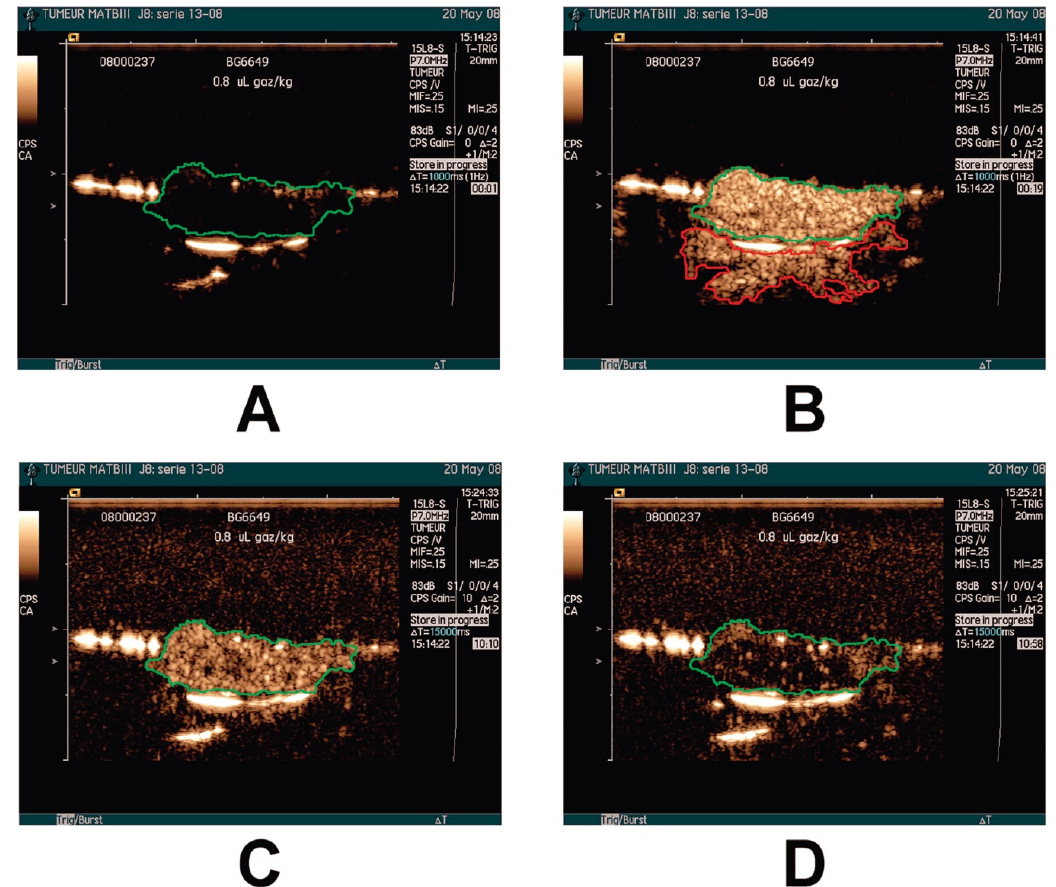
Figure 2. Ultrasound images of MAT B III tumors in CPS (Contrast Pulse Sequencing)mode. Green outline implied tumor; red outline implied nontumoral vasculature. ( A ) Before injection of the VEGFR2-targeted microbubbles (BR55); ( B ) At 20 s after injection of BR55 (peak intensity), the tumor vasculature and nontumoral vasculature shows hyperechoic; ( C ) At 10 min after injection of BR55, only the VEGFR2-targeted microbubbles are adherent to the tumor vasculature; ( D ) At 11 min, the microbubbles in the tumor were cleared and residual circulating bubbles were waiting for refilling of the tumor. Note: Copyright 2010, American Chemical Society.